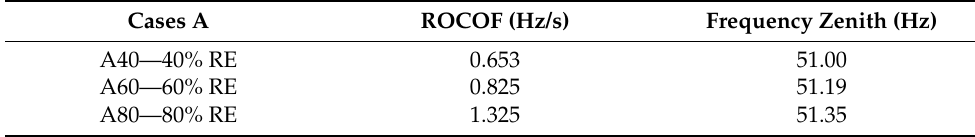
Figure 7. Frequency response of the system under different levels of RE penetration. Table 4. ROCOF and frequency zenith for Group A case studies. Table 4. ROCOF and frequency zenith for Group A case